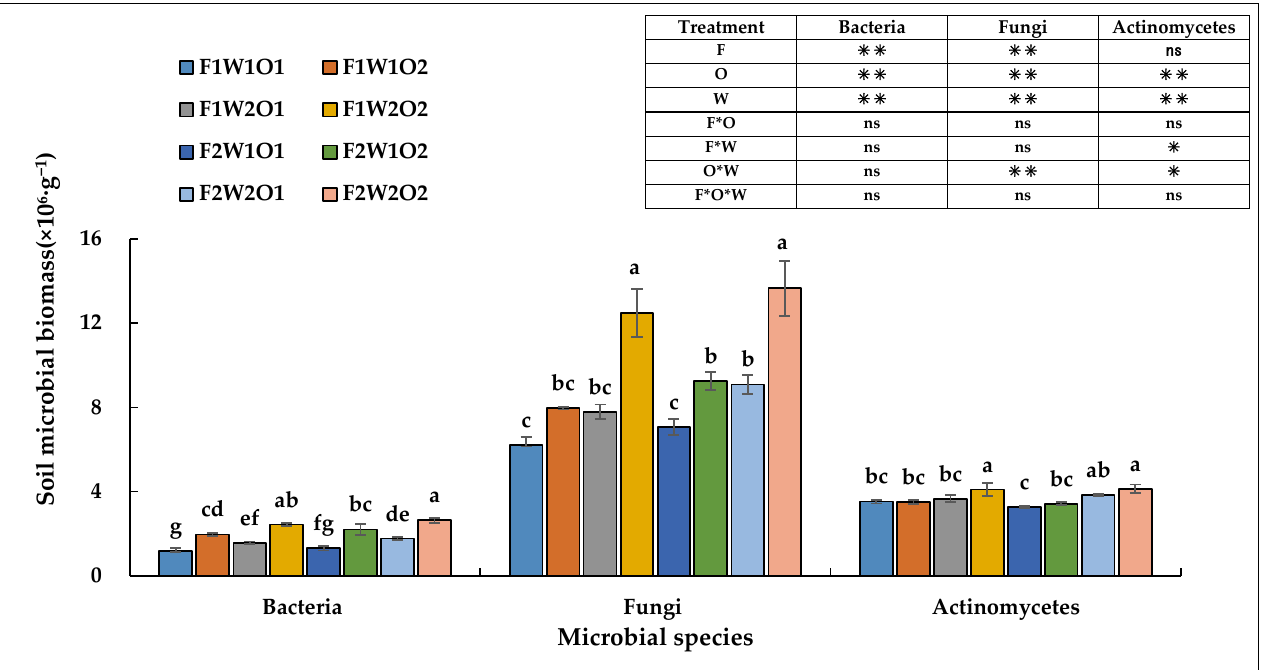
Figure 6. Analysis of variance of soil microbial biomass in the tomato root zone under different treatments. Note: F represents the fertilizer amount, O represents the oxygen amount, W represents the irrigation amount. Different letters indicate significant differences at the level of p < 0.05. * p < 0.05. ** p < 0.01. ns, not significant at p < 0.05.